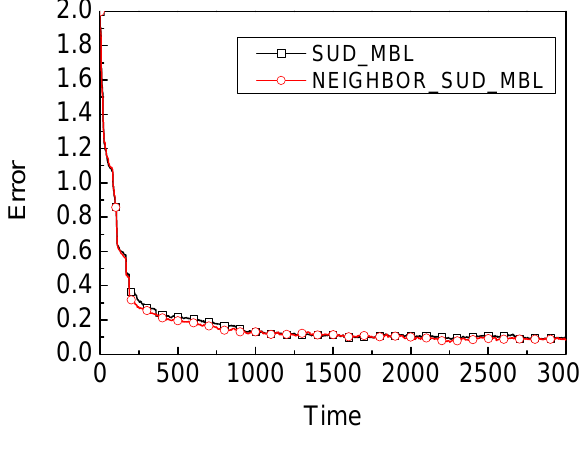
Figure 6. Comparison of neighbor’s impact when (Time ≥ 200) and (Time mod 200 =